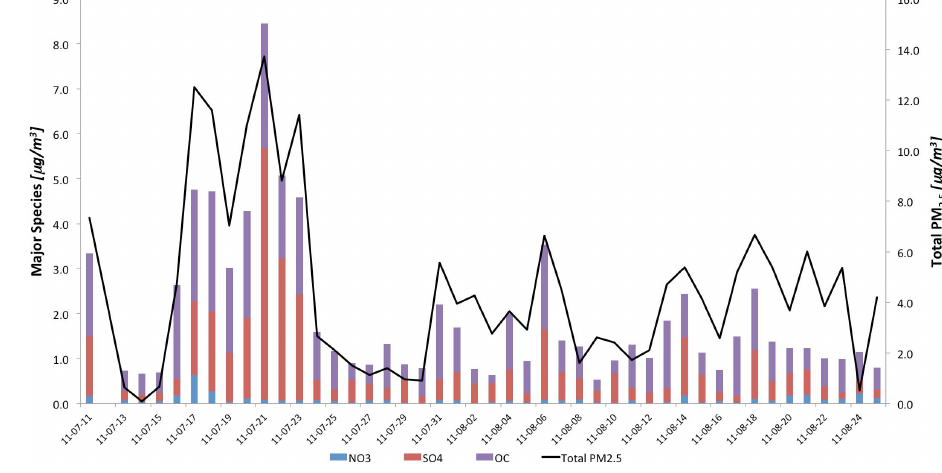
Fig. 4. Time series of total PM 2 . 5 mass and major species concentration.